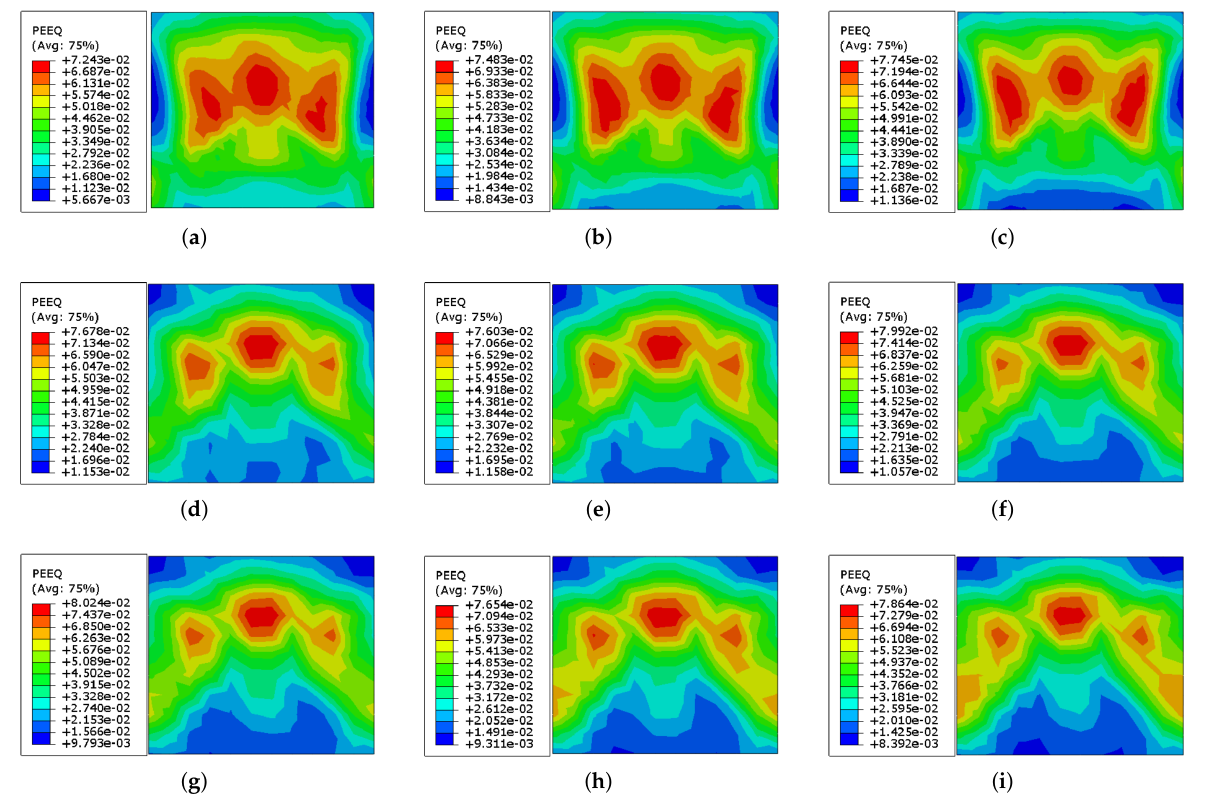
Figure 17. Equivalent plastic strain (˜ ε pl c ) distribution in the URM retrofitted with Ni–Ti strips with different thicknesses at the end of loading program shown in Figure 1: ( a ) Ni–Ti 1.0 mm; ( b ) Ni–Ti 1.5 mm; ( c ) Ni–Ti 2.0 mm; ( d ) Ni–Ti 2.5 mm; ( e ) Ni–Ti 3.0 mm; ( f ) Ni–Ti 3.5 mm; ( g ) Ni–Ti 4.0 mm;